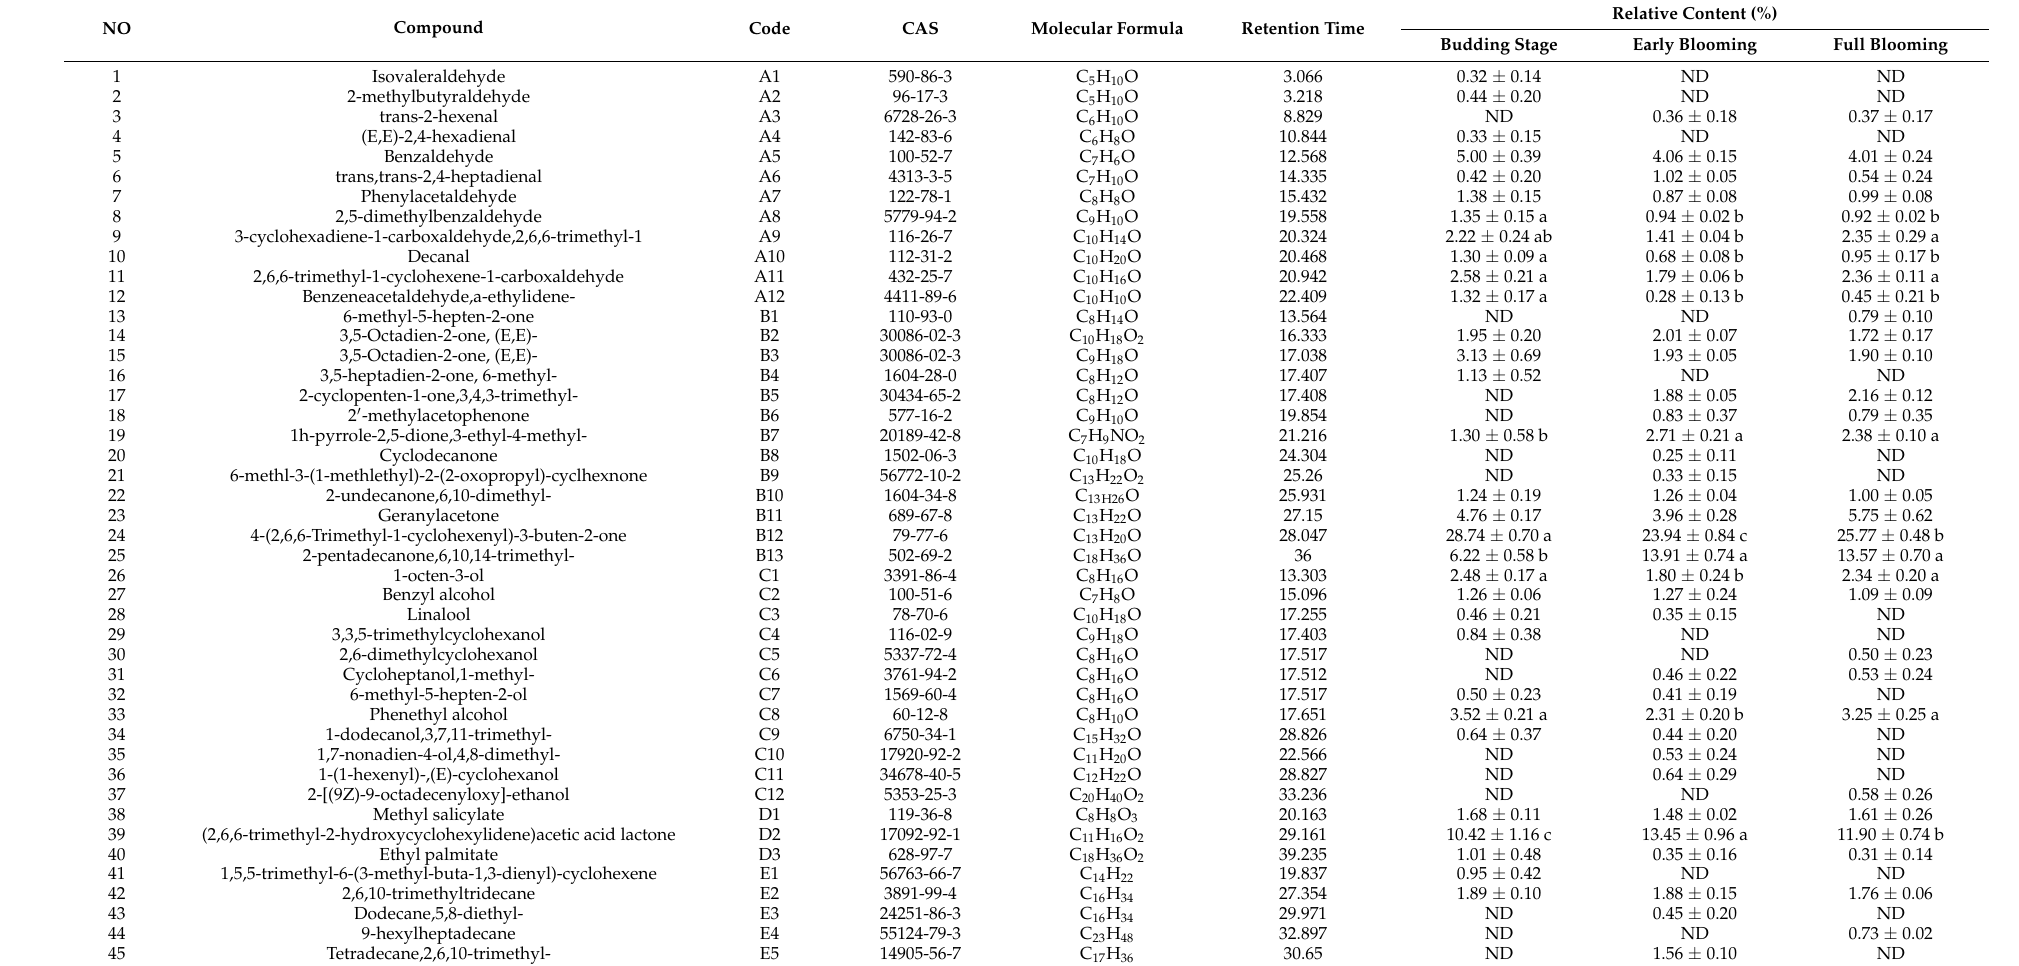
Table 1. VOCs types and relative content of alfalfa at different harvest